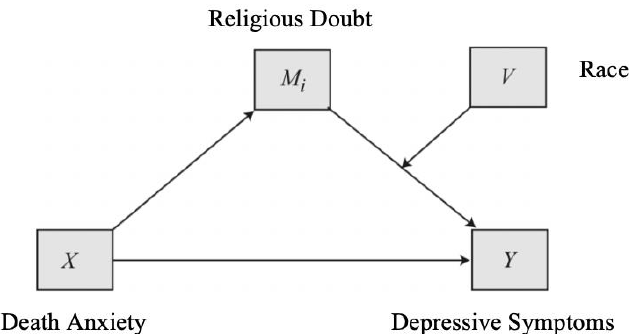
Figure 2. Conceptual diagram of the moderated mediation analysis.